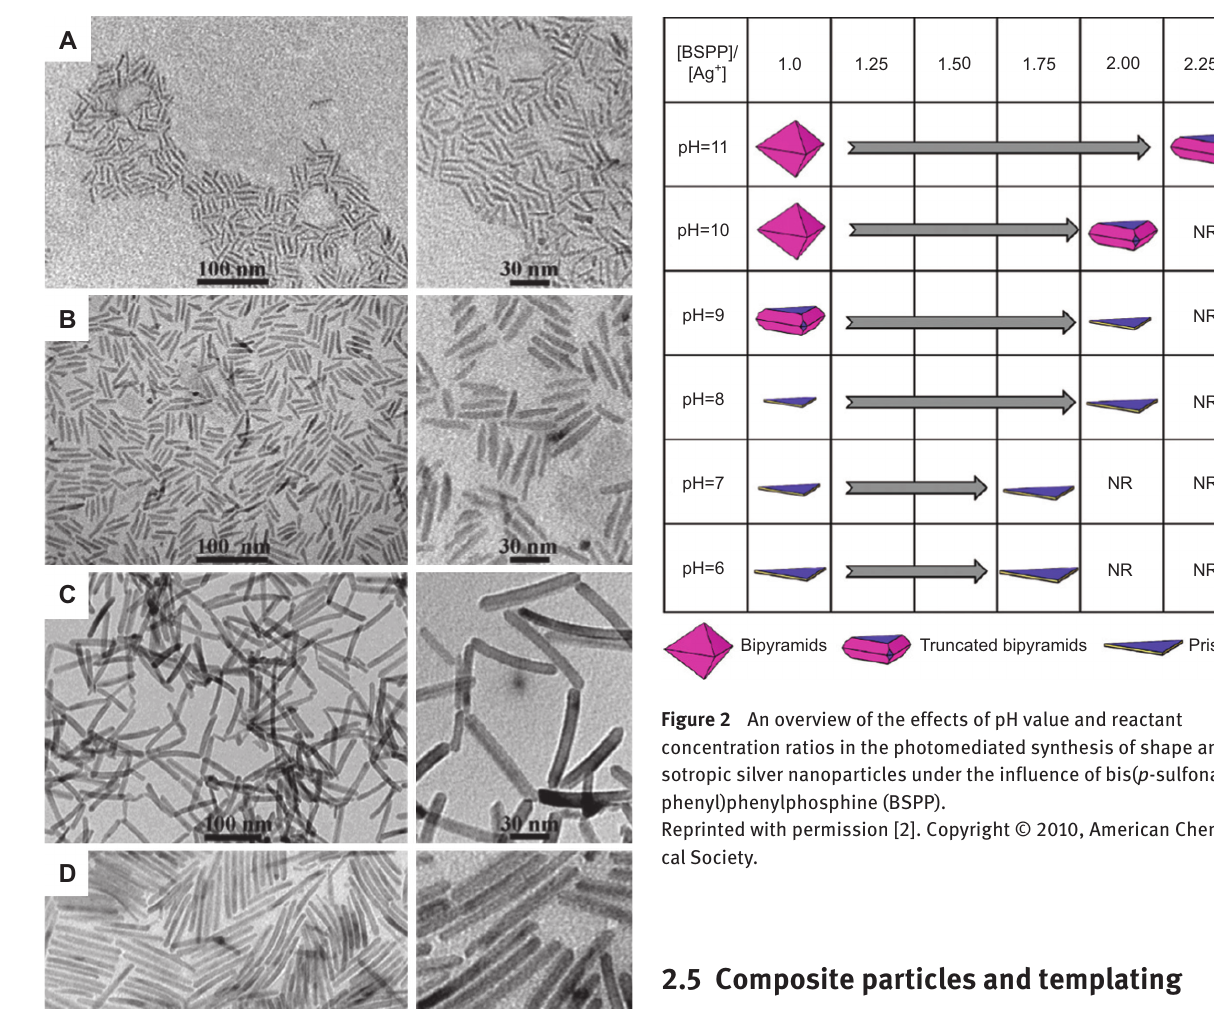
Figure 1 TEM images of TiO assisted nonaqueous synthesis strategy.